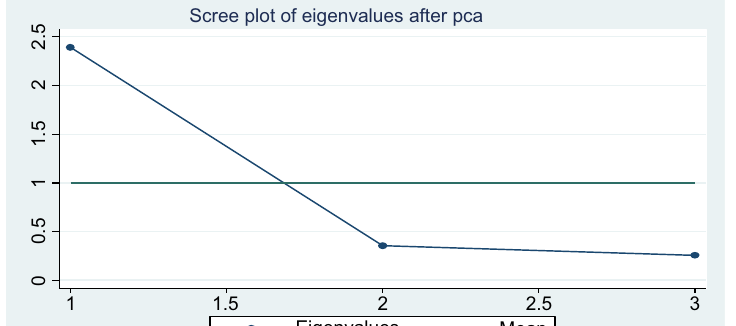
Figure 1. Scree plot of